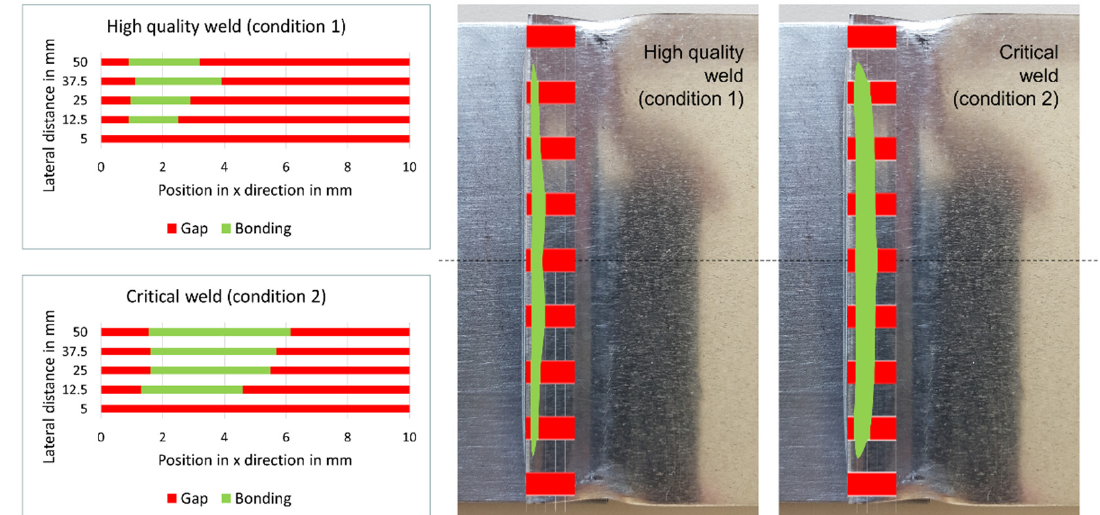
Figure 8. Measured width and assumed shape of the joining zones of a high-quality weld and a critical weld in order to visualize the significantly larger joining area (marked green) of the critical weld.